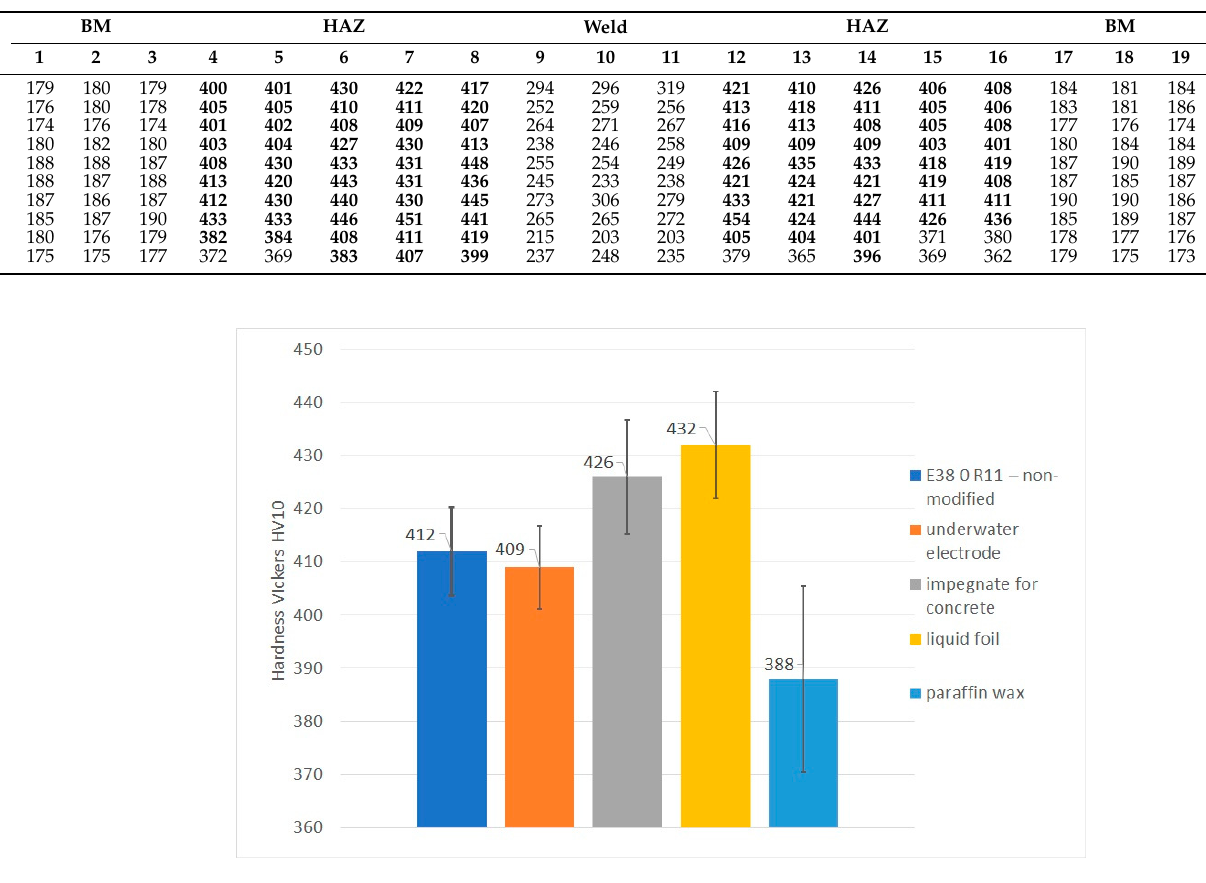
Table 5. The results of Vickers HV10 measurements.